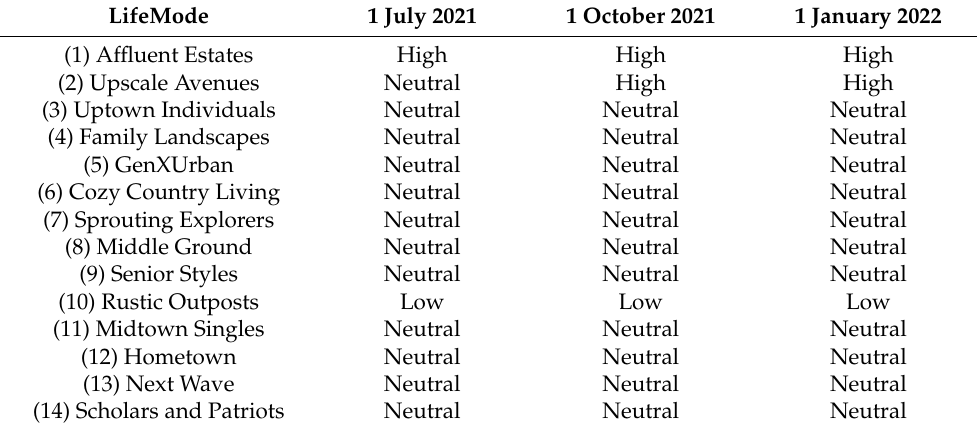
Table 1. Vaccination status for each LifeMode on 1 July 2021; 1 October 2021; and 1 January 2022.